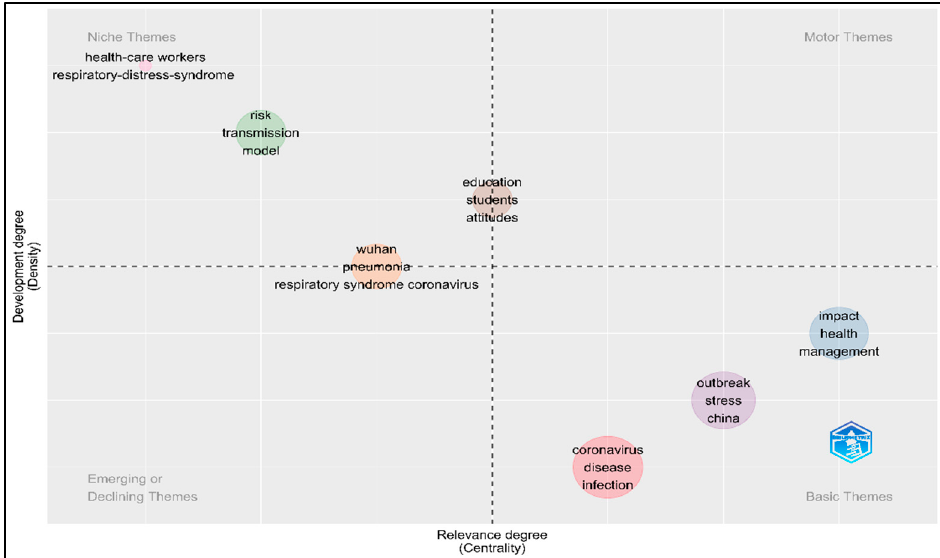
Figure 2. Thematic map based on KeyWords Plus.